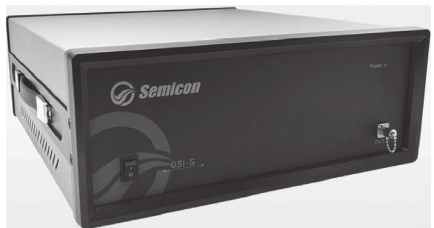
Figure 5: The Rayleigh OFDR-based interrogator (OSI-S by